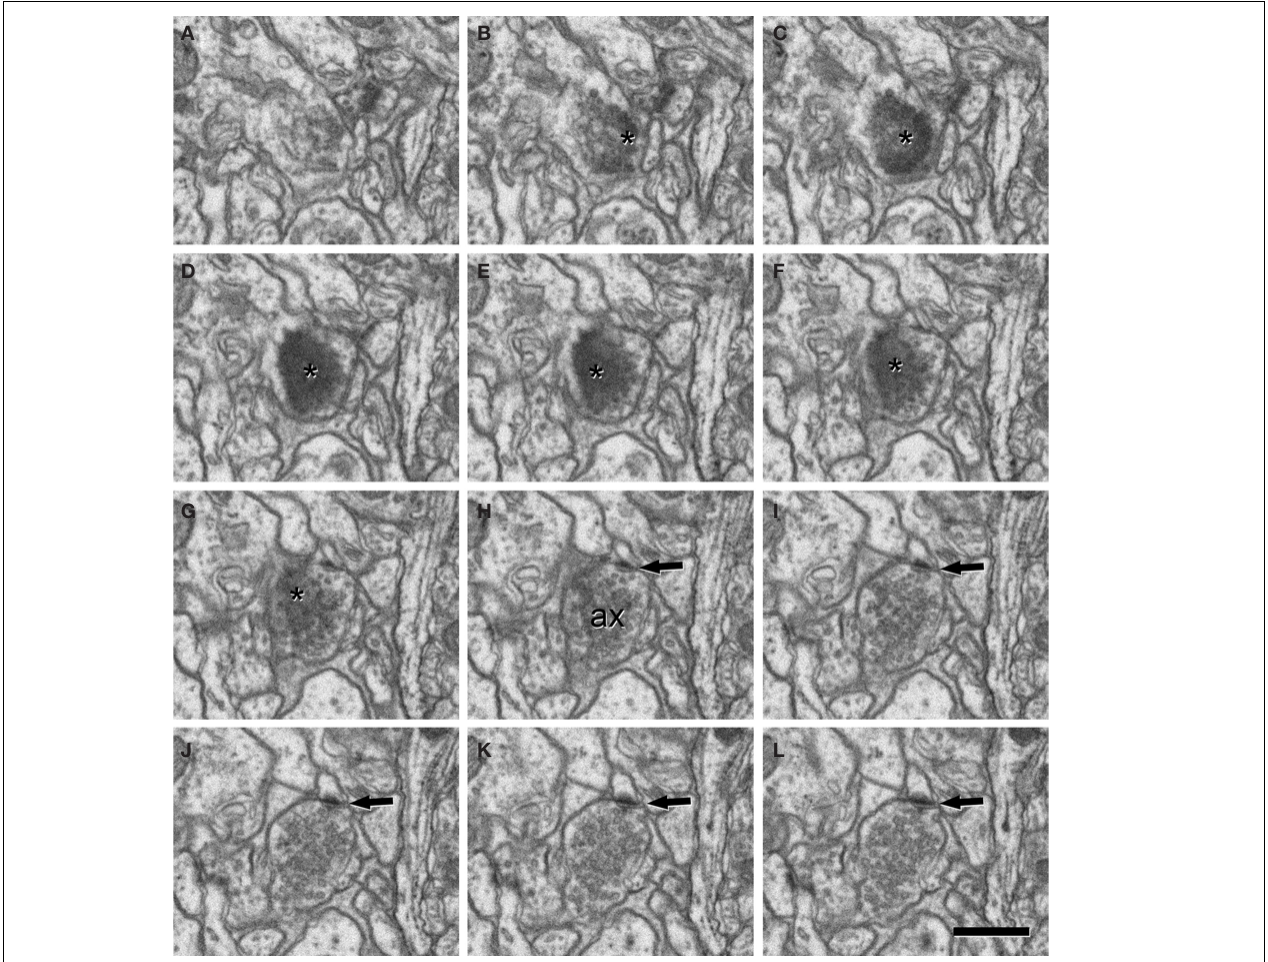
densities and the synaptic cleft, the total thickness is prominent enough to suggest that it is an asymmetric synapse (the pre-synaptic membrane specialization and the synaptic cleft would account for about 40–50 nm). This could be confi rmed because in the last four sections of the series, the pre- synaptic element [ax in (H) ], characterized by the presence of numerous synaptic vesicles, establishes a small synapse that is clearly asymmetric (arrows). Scale bar, 500